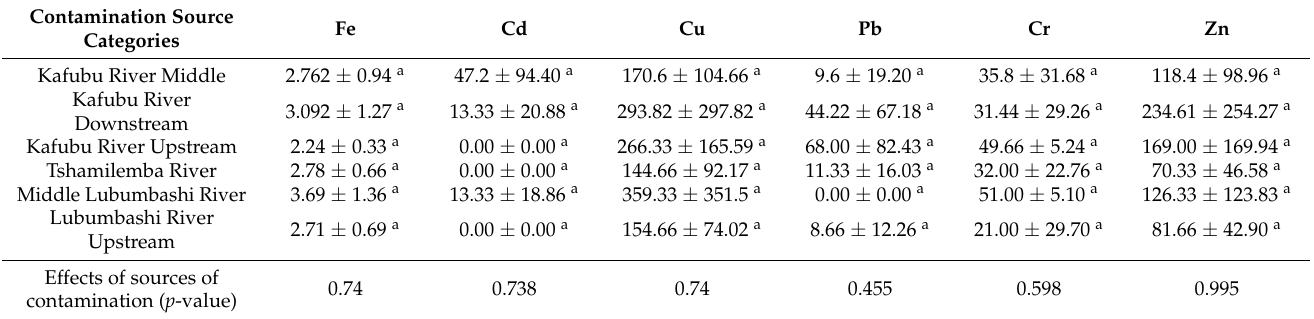
Table 2. XRF determination of metals in 29 urban and peri-urban market gardens of Lubumbashi (mg/kg).